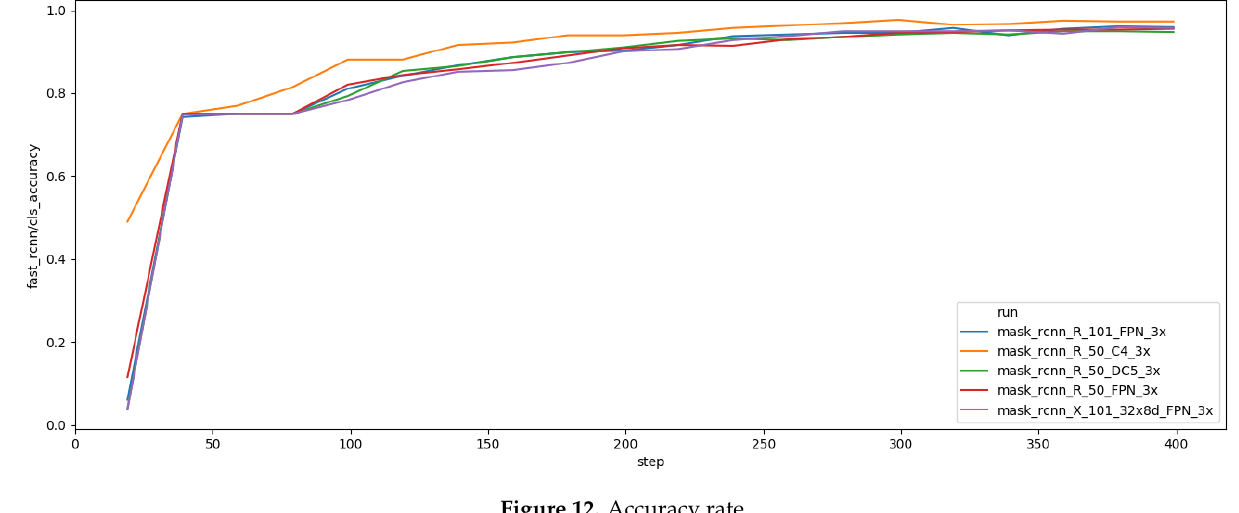
Figure 12. Accuracy rate.